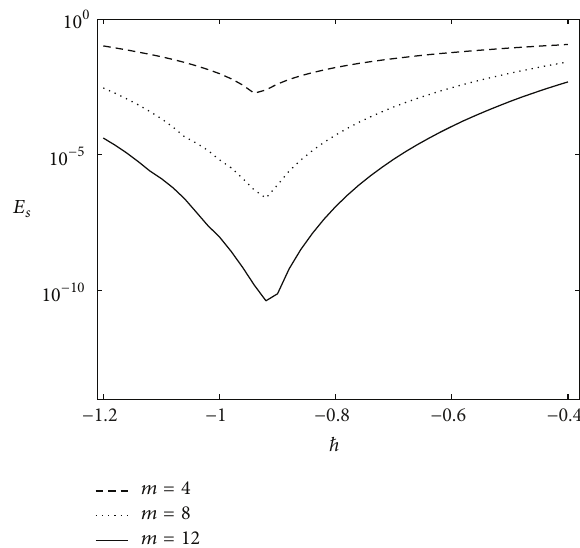
Figure 1: Residual ℎ -curve for Fisher’s equation at 𝑡 = 1 . Figure 2: Residual ℎ -curve for Burger-Fisher’s equation at 𝑡 = 1 .